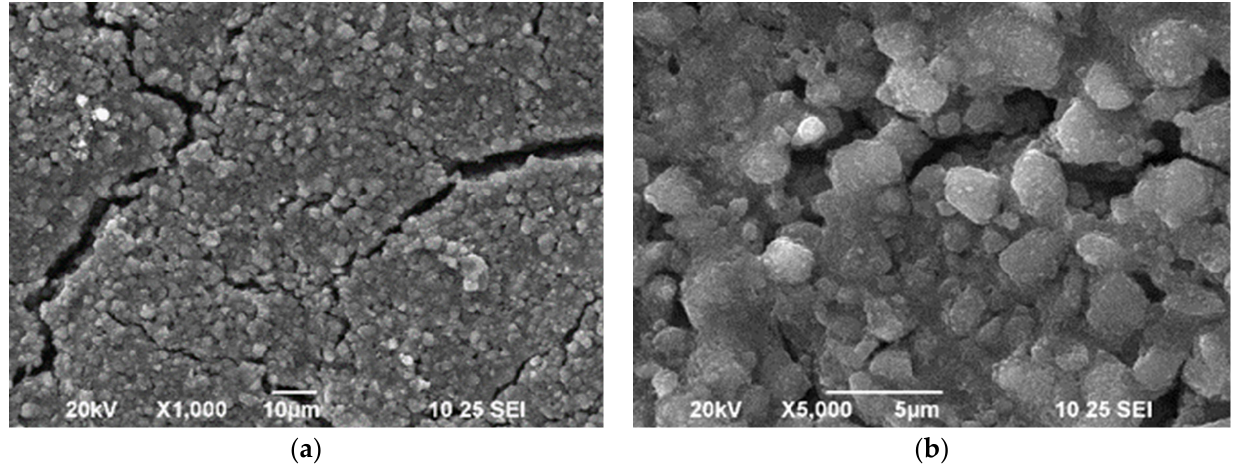
Figure 1. Morphology of the Ti/TiO 2 electrode with under ( a ) ×1000 and ( b ) ×5000 magnification.